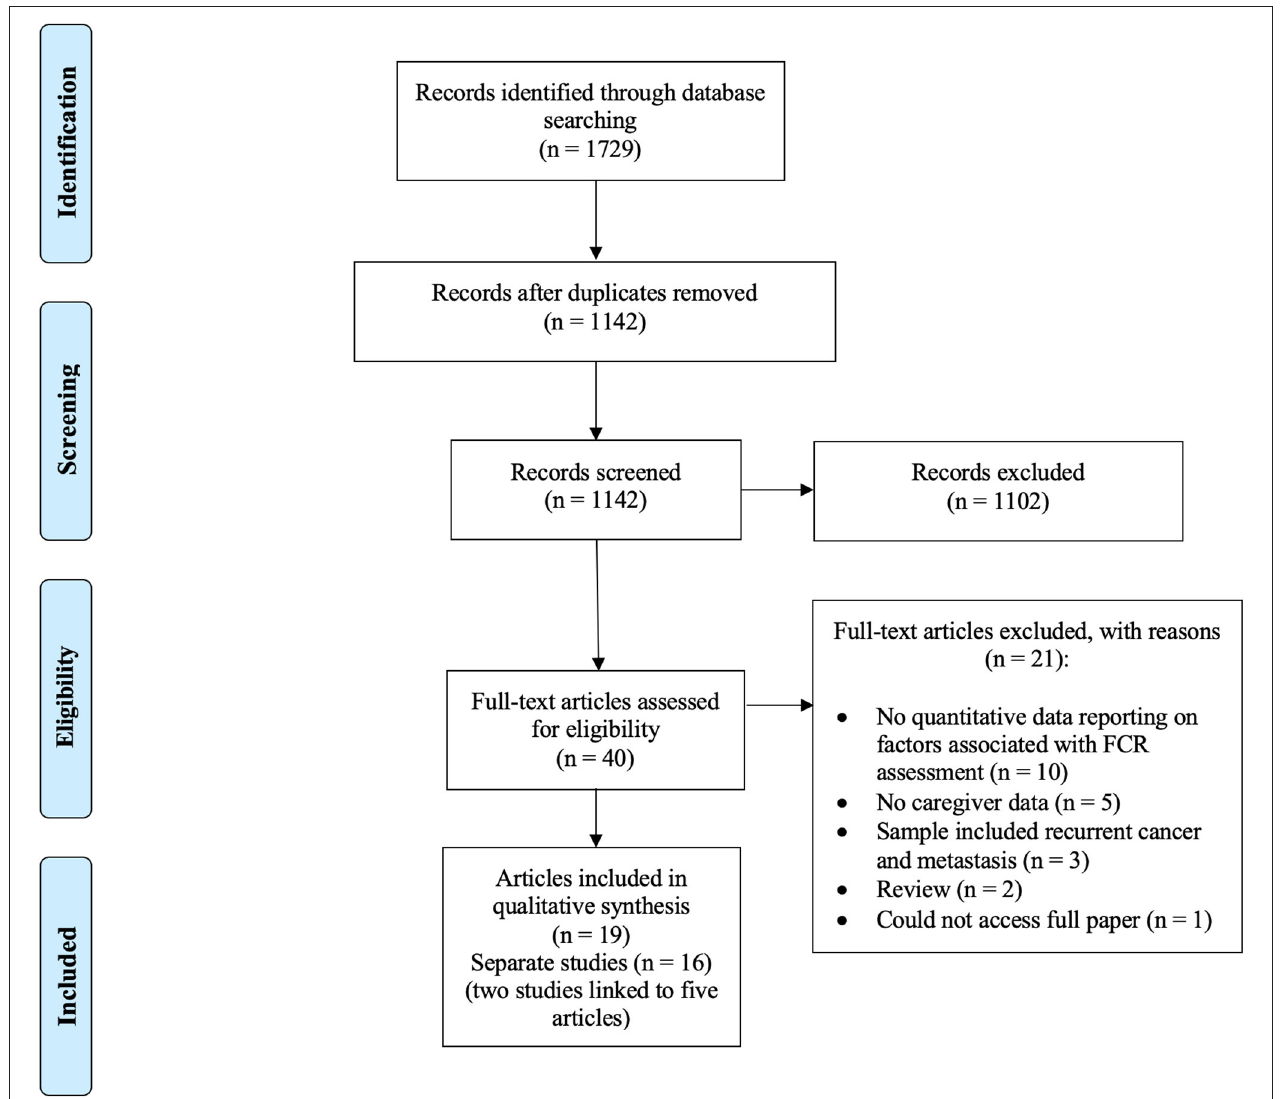
FIGURE 1 | Flowchart of literature search (based on PRISMA guidelines; Moher et al., 2009).